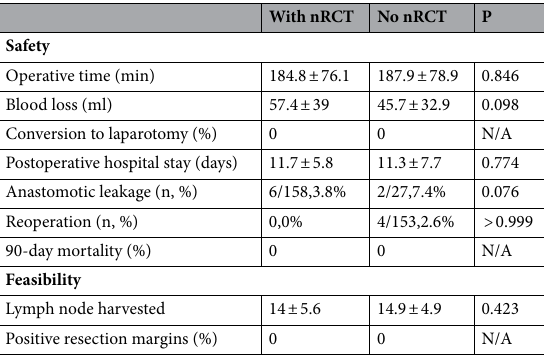
Table 5. Influence on robotic NOSES by nRCT.